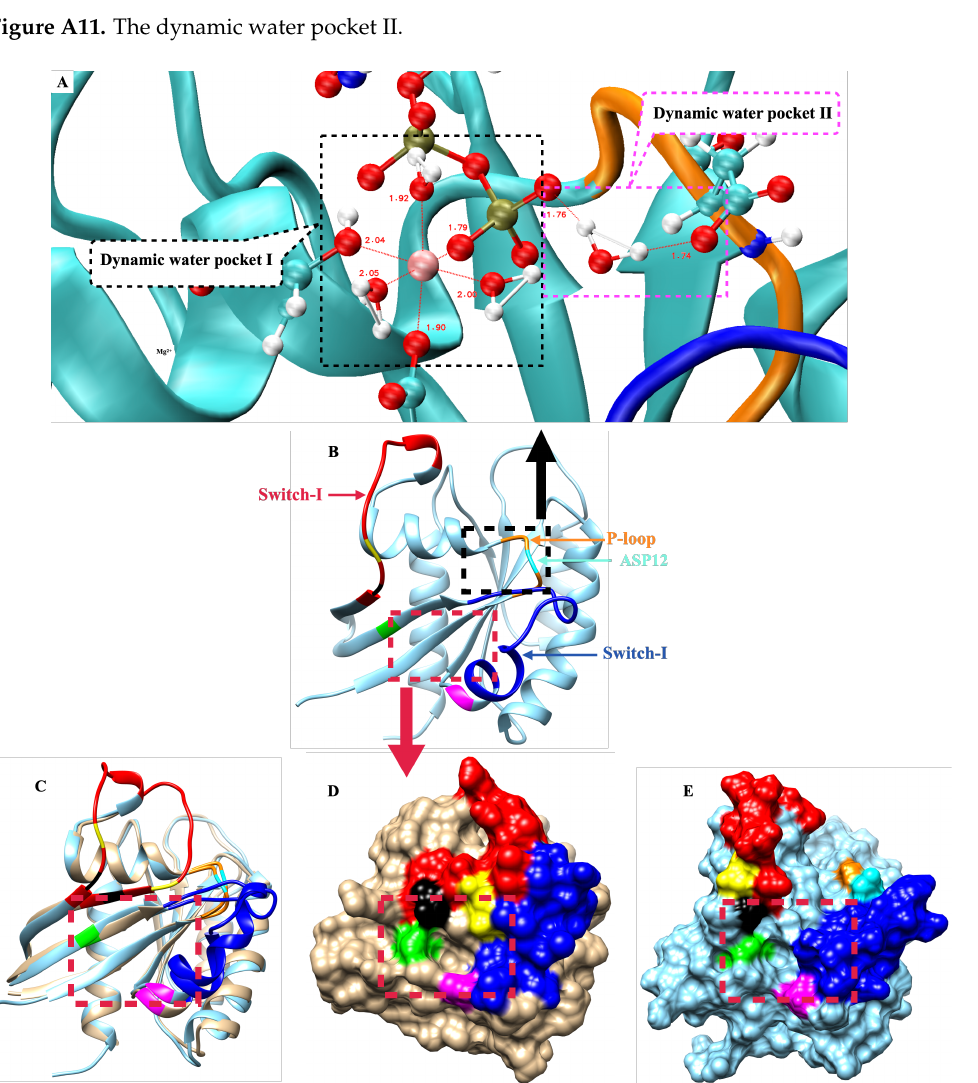
Figure A12. ( A ) The dynamic pockets I and II. ( B ) The most dominant conformation in our simulation results, black box: dynamic pockets I and II; red box: the pocket III. ( C ) Comparison of our simulation results with the crystal structure 6GJ7 (BI-2852, GDP, water and Mg2+ were hidden; red box: the location of pocket III, PDB ID code 6GJ7). ( D ) The surface version of crystal structure 6GJ7 (BI-2852 was hidden, PDB ID code 6GJ7). ( E ) The surface version of the most dominant conformation in our simulation results. Yellow: GLU37, Black: SER39, Green: ASP54, Magenta: THR74. Red box: the targetable pockets reported by Kessler et al. [28] and in the present KRAS-G12D simulation